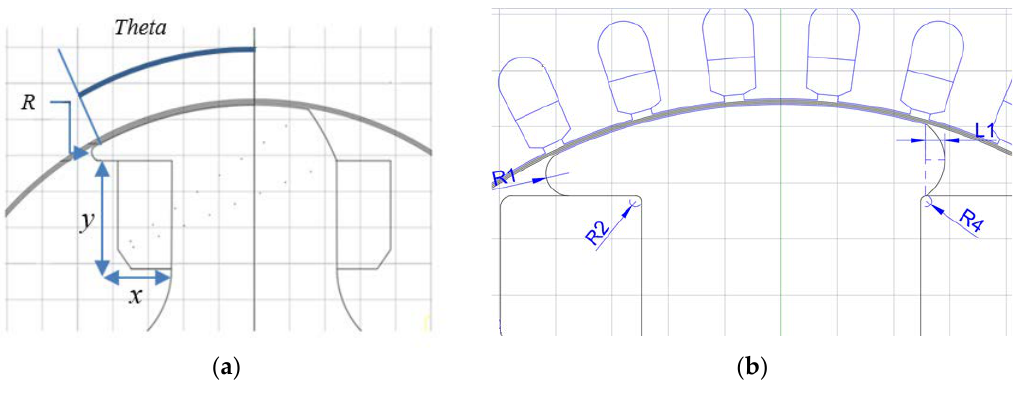
Figure 6. Advanced problem definition. ( a ) Design 1; ( b ) Design 2.